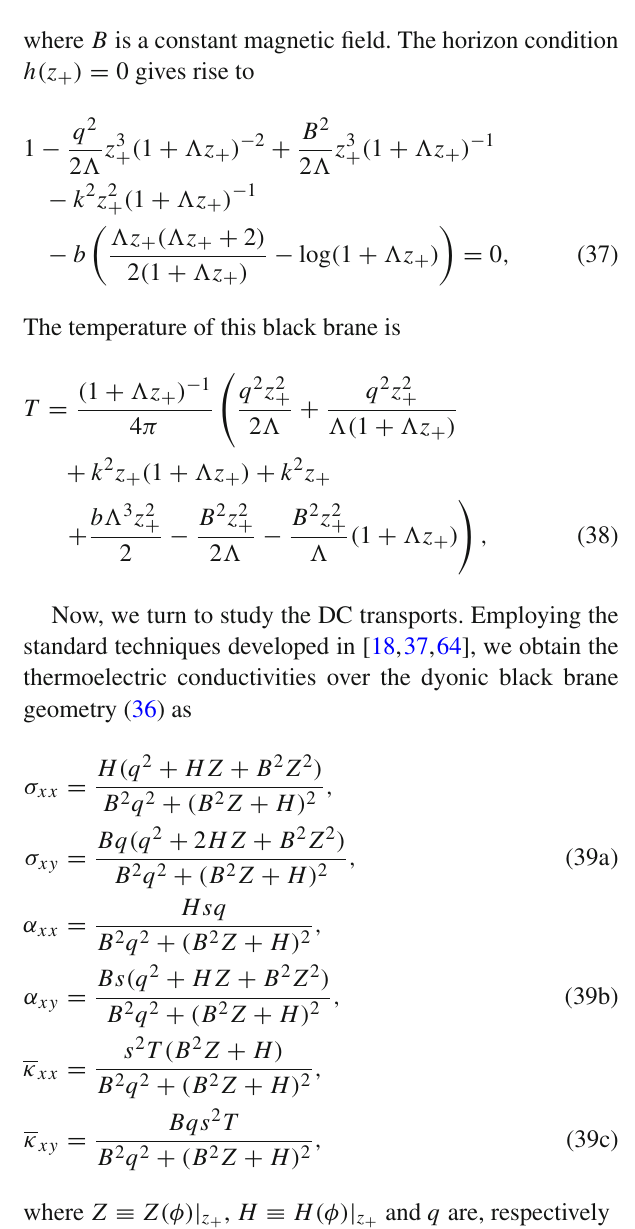
Table 1 The exact value of (cid:6) and the temperature T obtained by the expressions in (30) and (33), which is presented in the second and third rows, and the approximate results obtained in terms of the first equation in Eq. (34), which is presented in the fourth and fifth rows